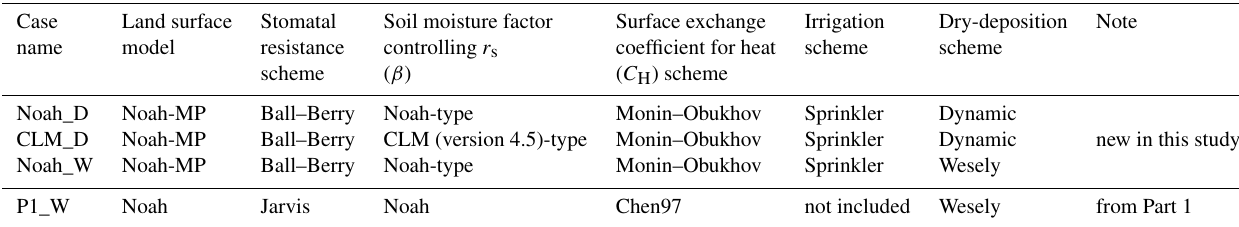
Table 1. Model cases and their configurations relevant to the discussions of this study. Case Land surface Stomatal Soil moisture factor Surface exchange Irrigation